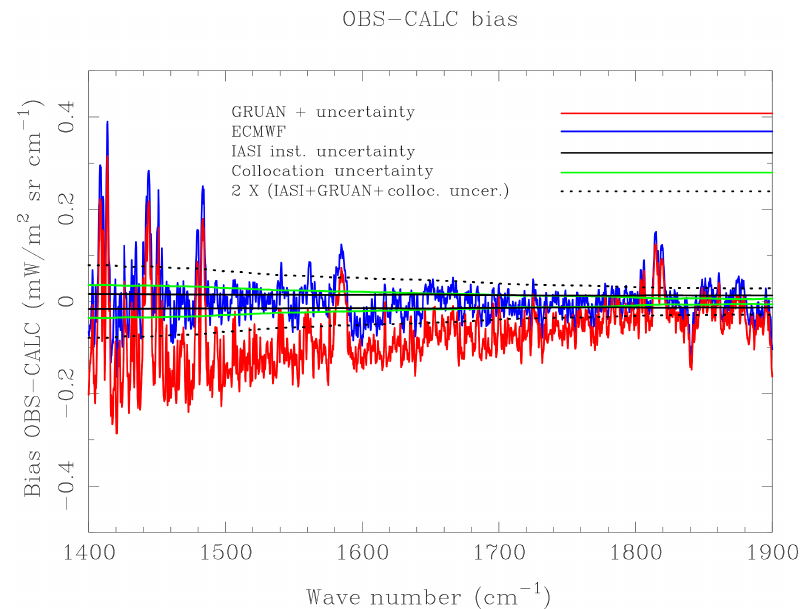
Figure 7. Average radiance difference (bias) between IASI observed and calculated radiances for the completely clear sky scenes and daytime cases. Calculated radiances are derived from GRUAN sondes (red) and ECMWF profiles (blue). The thickness of the red line (hardly noticeable) denotes the GRUAN uncertainty propagated into bias radiance space assuming no uncertainty correlation between levels. The solid black line shows the IASI instrument uncertainty for this bias. The light green line indicates the collocation uncertainty of this average or bias. The dotted black line indicates 2 times the square root of the squares of the IASI overall instrument plus GRUAN uncertainties plus